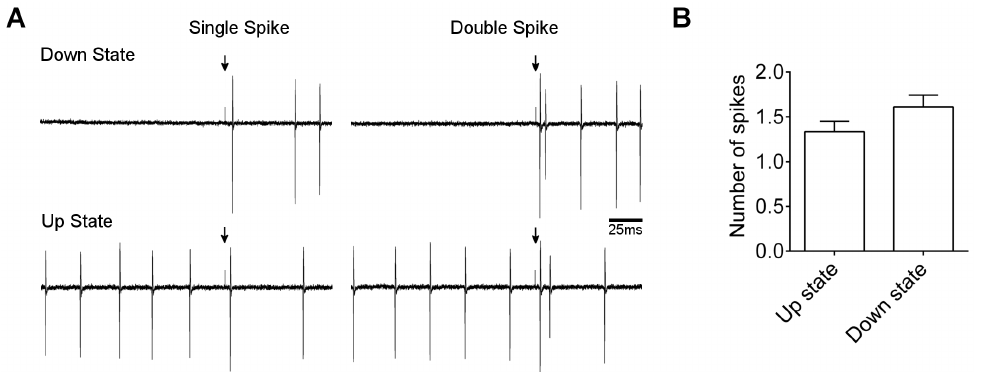
Figure 5. Effect of resting membrane state on number of post-stimulus spikes. A) Loose cell recordings from cells showing single post- stimulus spikes (left traces) or double post-stimulus spikes (right traces), evoked from down state (upper traces) or up state (lower traces). B) Mean 6 s.e.m. number of post-stimulus spikes from cells in up or down states (n=6). No significant difference between up and down state was detected: p=0.084, paired t test.